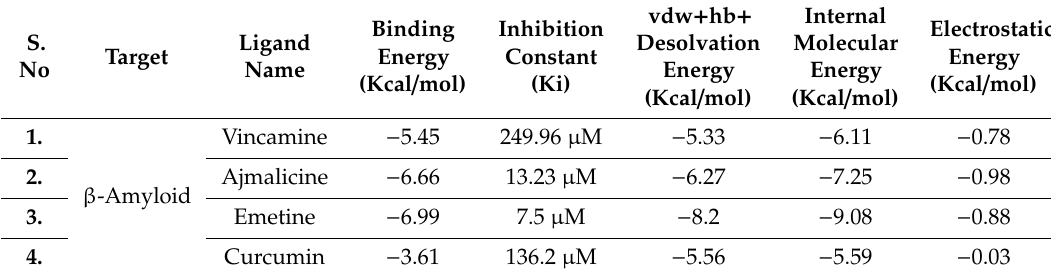
Table 2. Interaction energies of A β with ligands (Kcal / mol) obtained from molecular docking analysis.